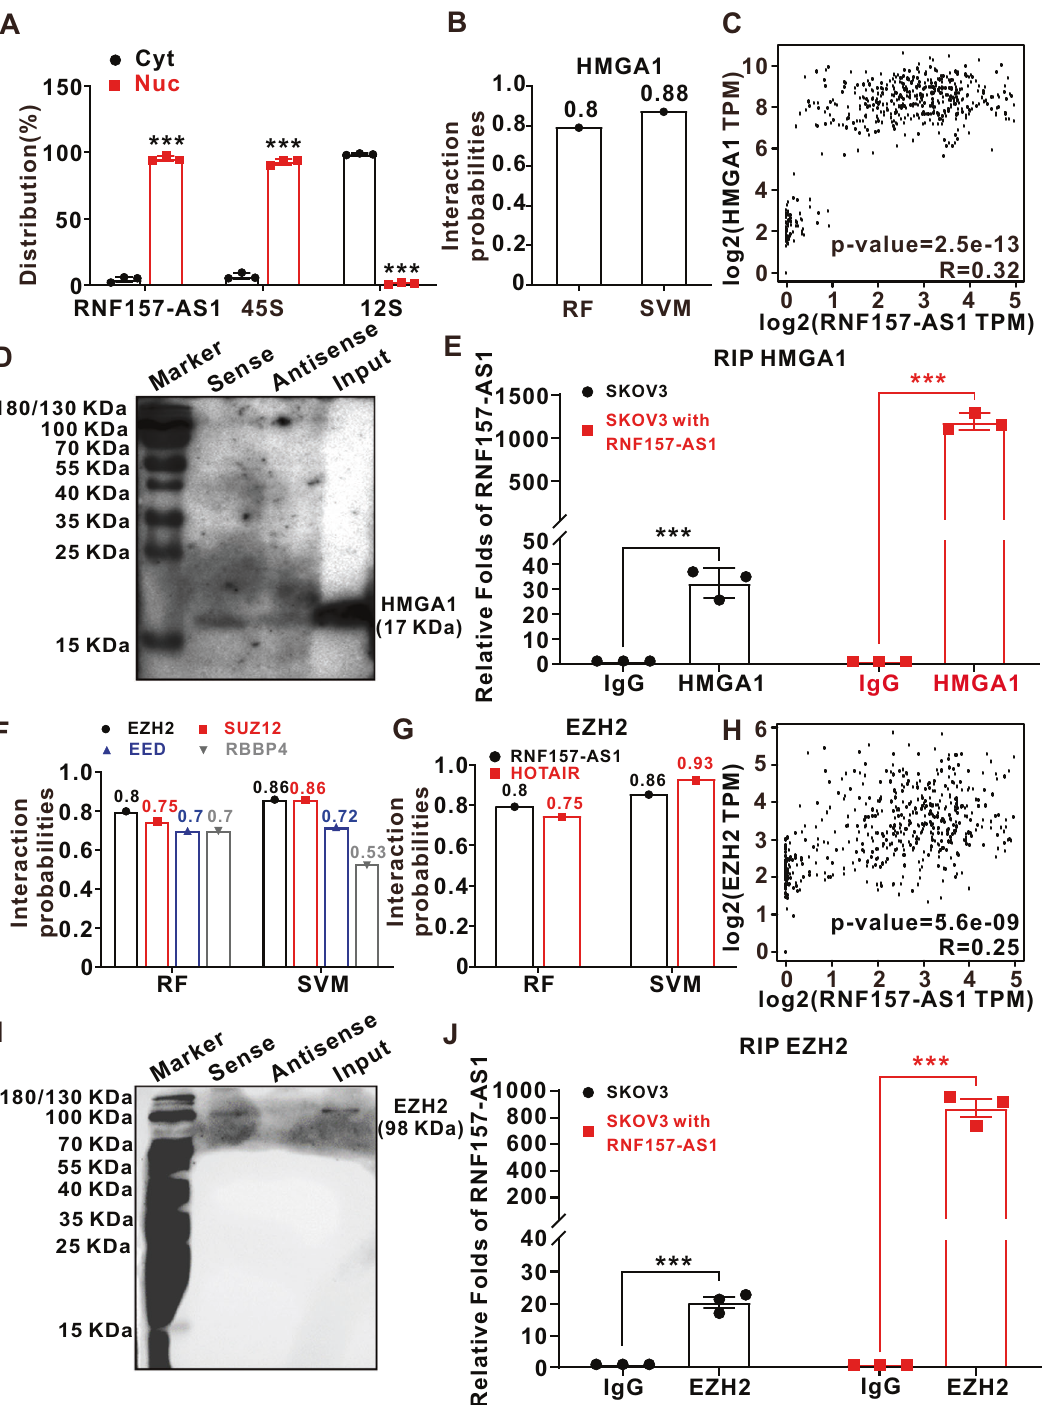
Fig. 3 RNF157-AS1 interacted with HMGA1 and EZH2 in the nucleus. A Subcellular localization analysis suggested that RNF157-AS1 was localized mainly in the nucleus in EOC cells. B The RPISeq database showed that RNF157-AS1 had a very high interaction predicting score with HMGA1 protein (RF:0.8; SVM:0.88). C RNF157-AS1 expression had a positive correlation with HMGA1 expression ( R = 0.32, P = 2.5*10 − 13 ) according to the GEPIA database. D Western blot analysis showed that RNF157-AS1 pulled down a greater amount of protein than did the control. E The RIP assay suggested HMGA1 interacted with RNF157-AS1 in not only RNF157-AS1 overexpression but also control EOC cells. F According to the RPISeq database, EZH2 had the highest interaction predicting score with RNF157-AS1 among the four subunits of the PRC2 complex. G EZH2 had a similar interaction predicting scores between RNF157-AS1 and HOTAIR; H RNF157-AS1 had a positive correlation with HMGA1 ( R = 0.25, P = 5.6*10 − 9 ) according to the GEPIA database. I Western blot analysis showed that EZH2 was present only in the RNF157-AS1 (sense) precipitate compared with the control (antisense) precipitate. J The RIP assay suggested EZH2 interacted with RNF157- AS1 in not only RNF157-AS1 overexpressing but also control EOC cells. Data were obtained from at least three independent experiments. *** P < 0.001 ( t